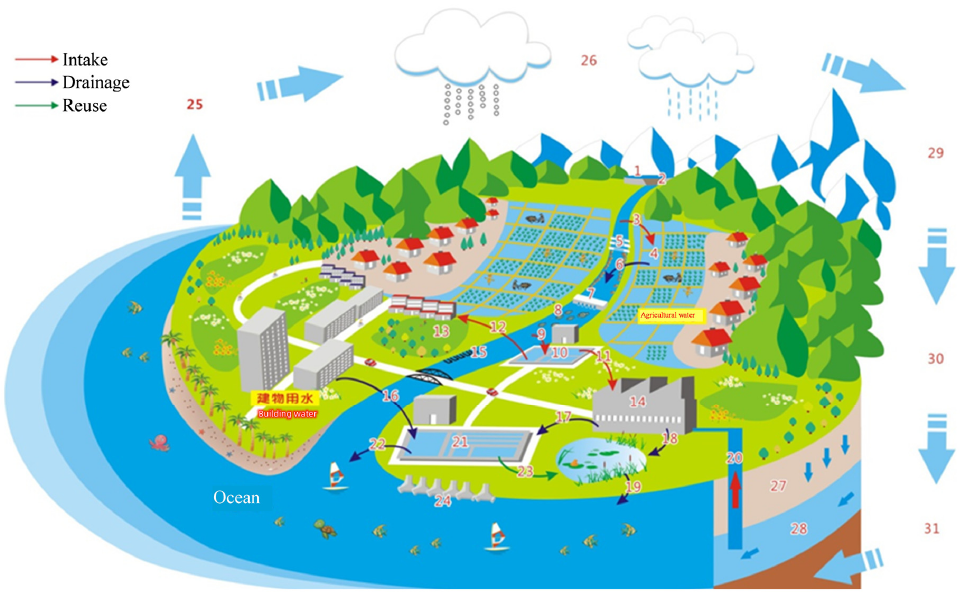
Figure 1. Water world map. Reproduced with permission from Han-Chung Yang, Water Resources Primary School; published by Shu-Chuan Publishing House, 2015 [30].